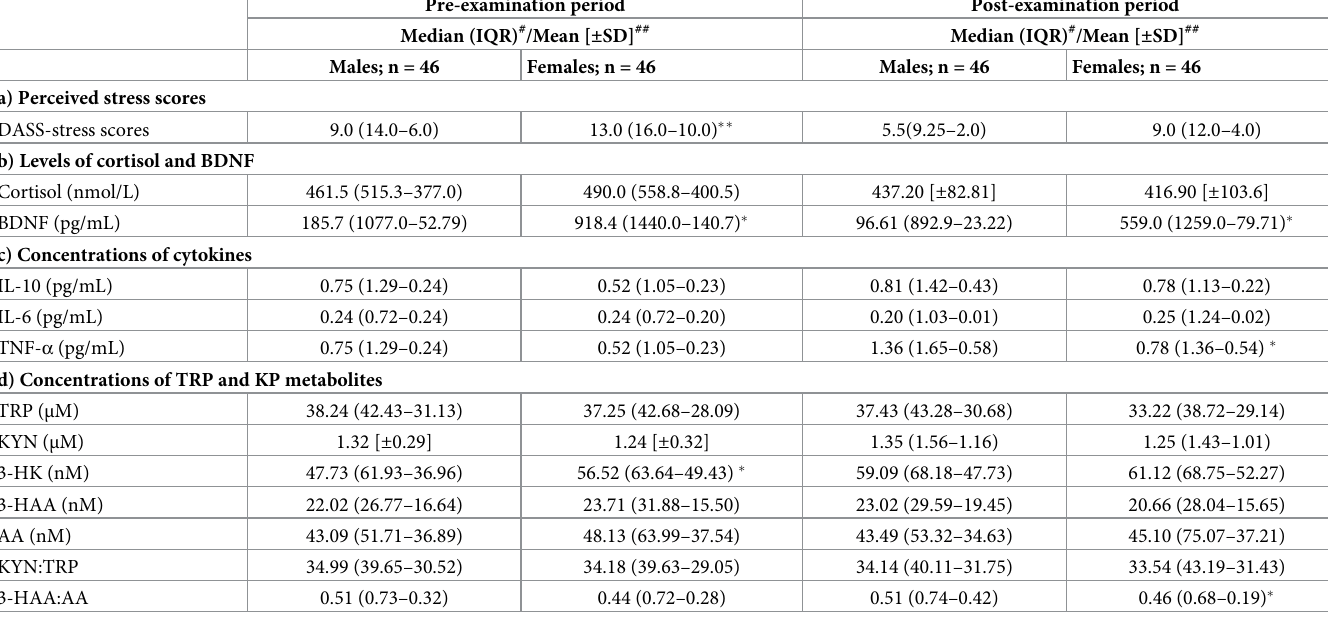
Table 2. Gender differences in a) perceived stress scores, b) the levels of cortisol and BDNF, c) concentrations of cytokines, and d) concentrations of TRP and KP metab- olites during pre-examination and post-examination